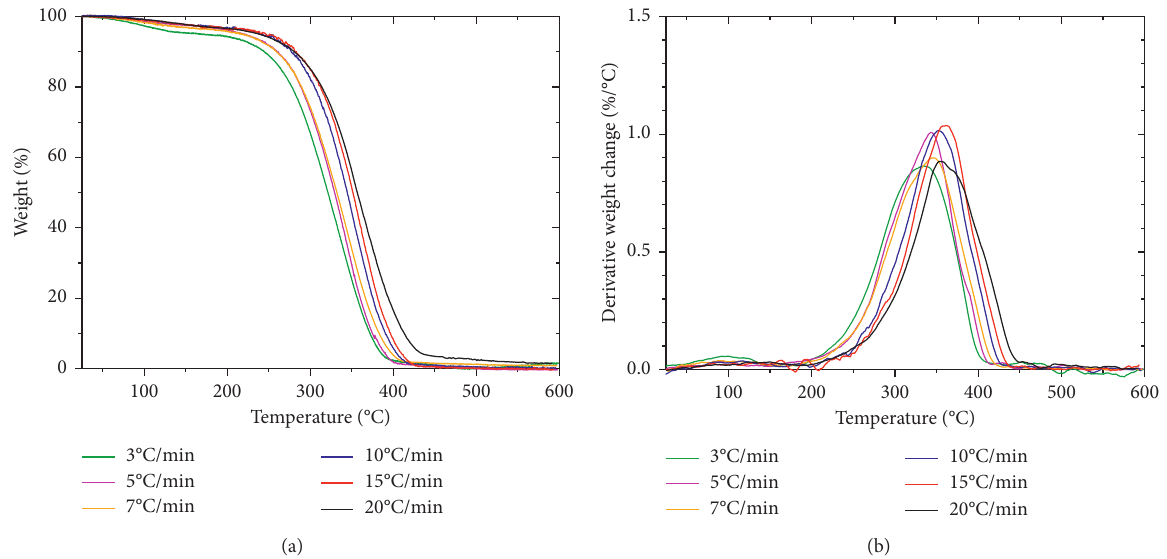
Figure 1: (a) TGA curves for sample PNVP- co -PSMA 20–80 under different heating rates. (b) Derivative weight loss with temperature for sample PNVP-co-PSMA 20–80 under different heating